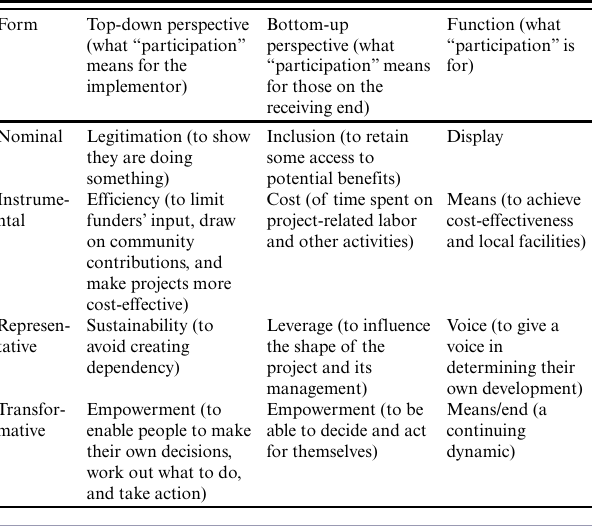
Table 2. White’s (1996) framework for analyzing the diversity of form, function, and interest within participation. Adaptations by Cornwall (2008) in